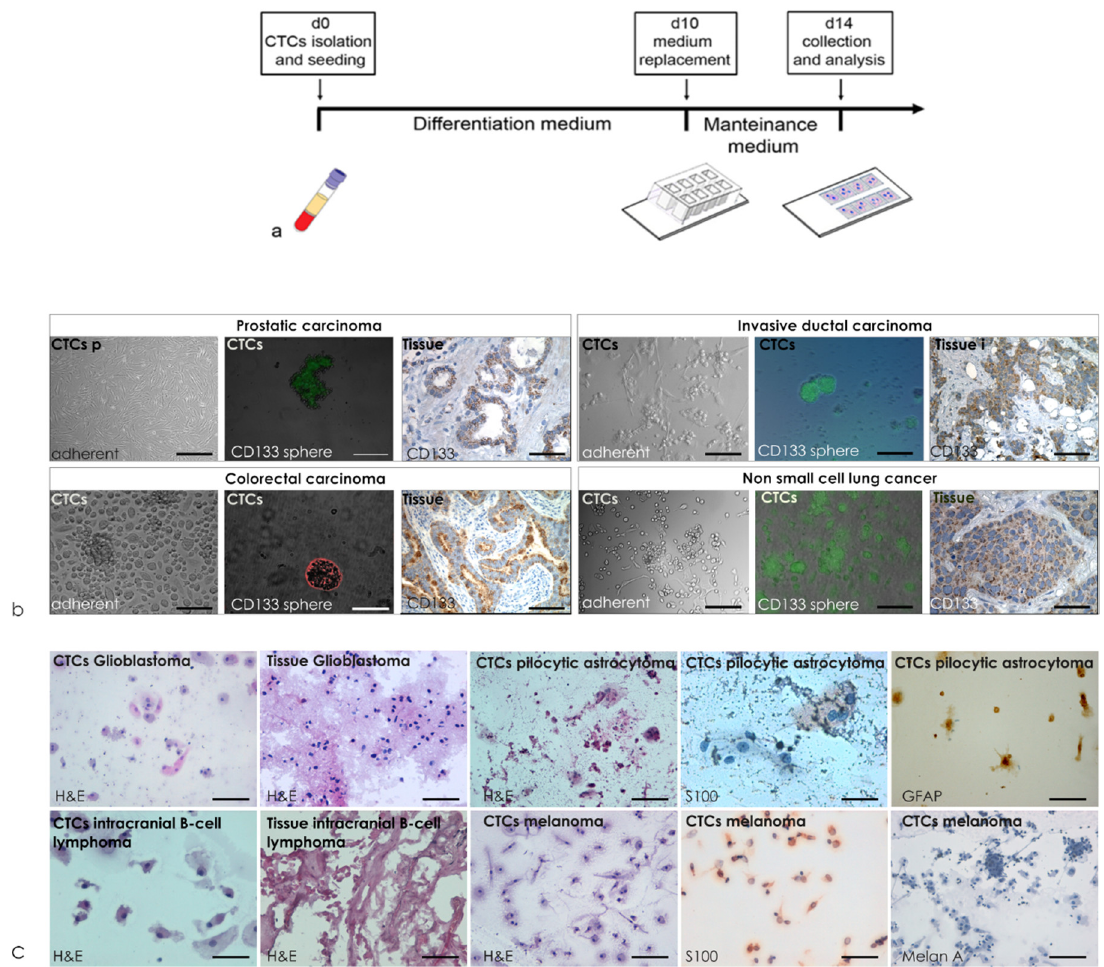
Figure 2. Graphic representation of the short-time blood derived cultures. ( a ) Isolation of a heterogeneous pool of circulating tumor cells (CTCs) seeded directly on slide-chambers and ( b ) on plates with a specific medium culture; ( c ) on day fourteen, the chambers were removed and the cells adherent on both were used for cytological evaluation (scale bars 10 μm).